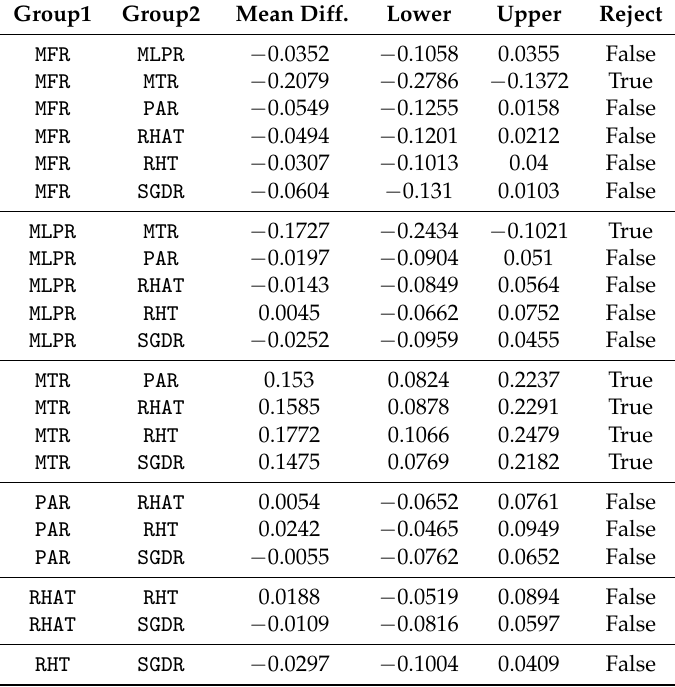
Table 15. Results of the Tukey’s range test for experiment